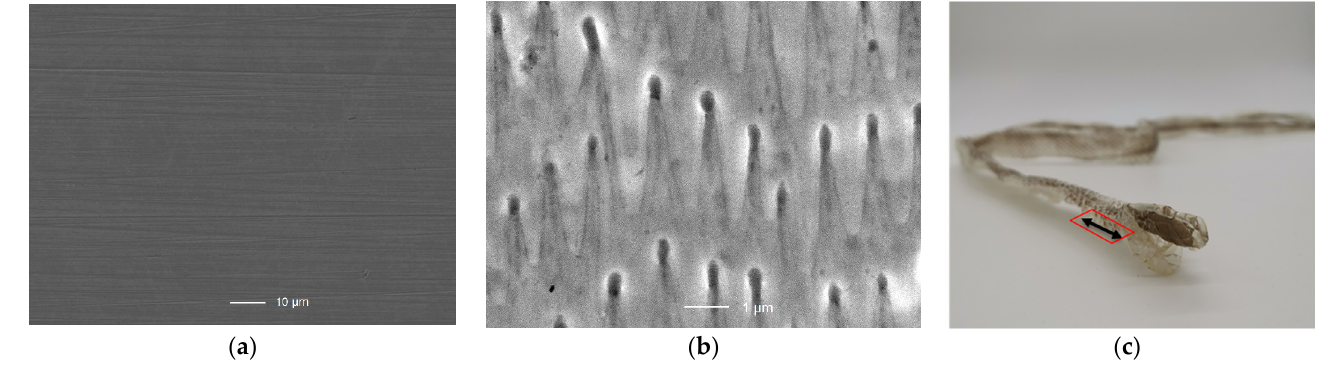
Figure 1. Reference structure of formed surfaces: ( a ) linear brushed/polished surface for anisotropic microstructures; ( b ) in nickel, the cast abdominal skin of the California king snake and the chosen 0° orientation of gliding for investigation ( c ).